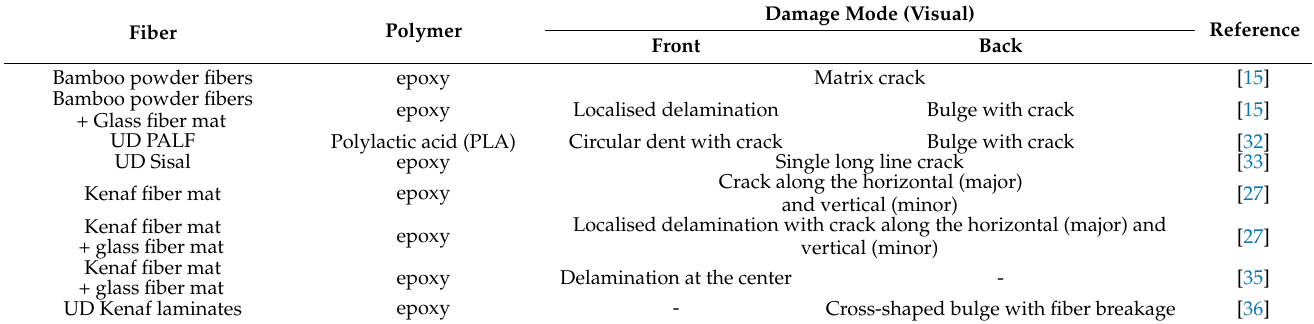
Table 3. Natural fiber and its hybrid composite damage associated with LVI.